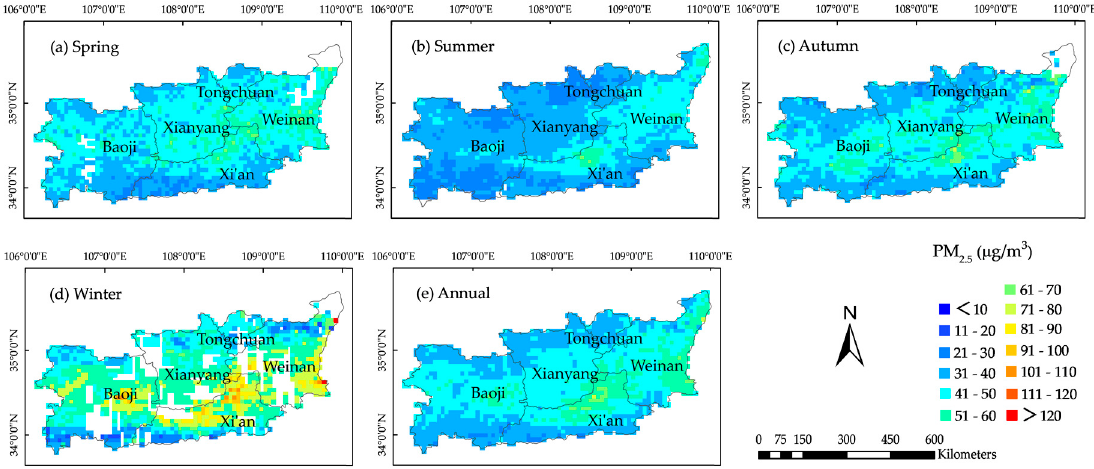
Figure 7. PM 2.5 concentrations in the Guanzhong Basin as predicted by the LME model, averaged over the year 2017 and for each of the seasons in 2017.